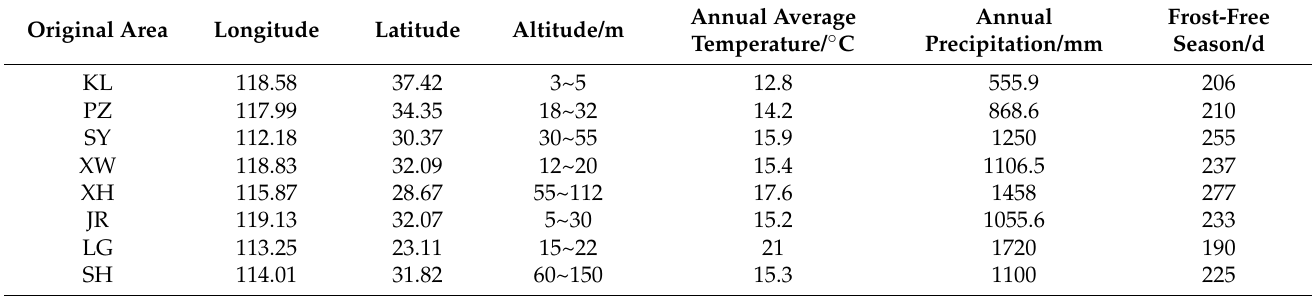
Table 1. Location and climatic conditions of the Melia azedarach. L seed collection sites in